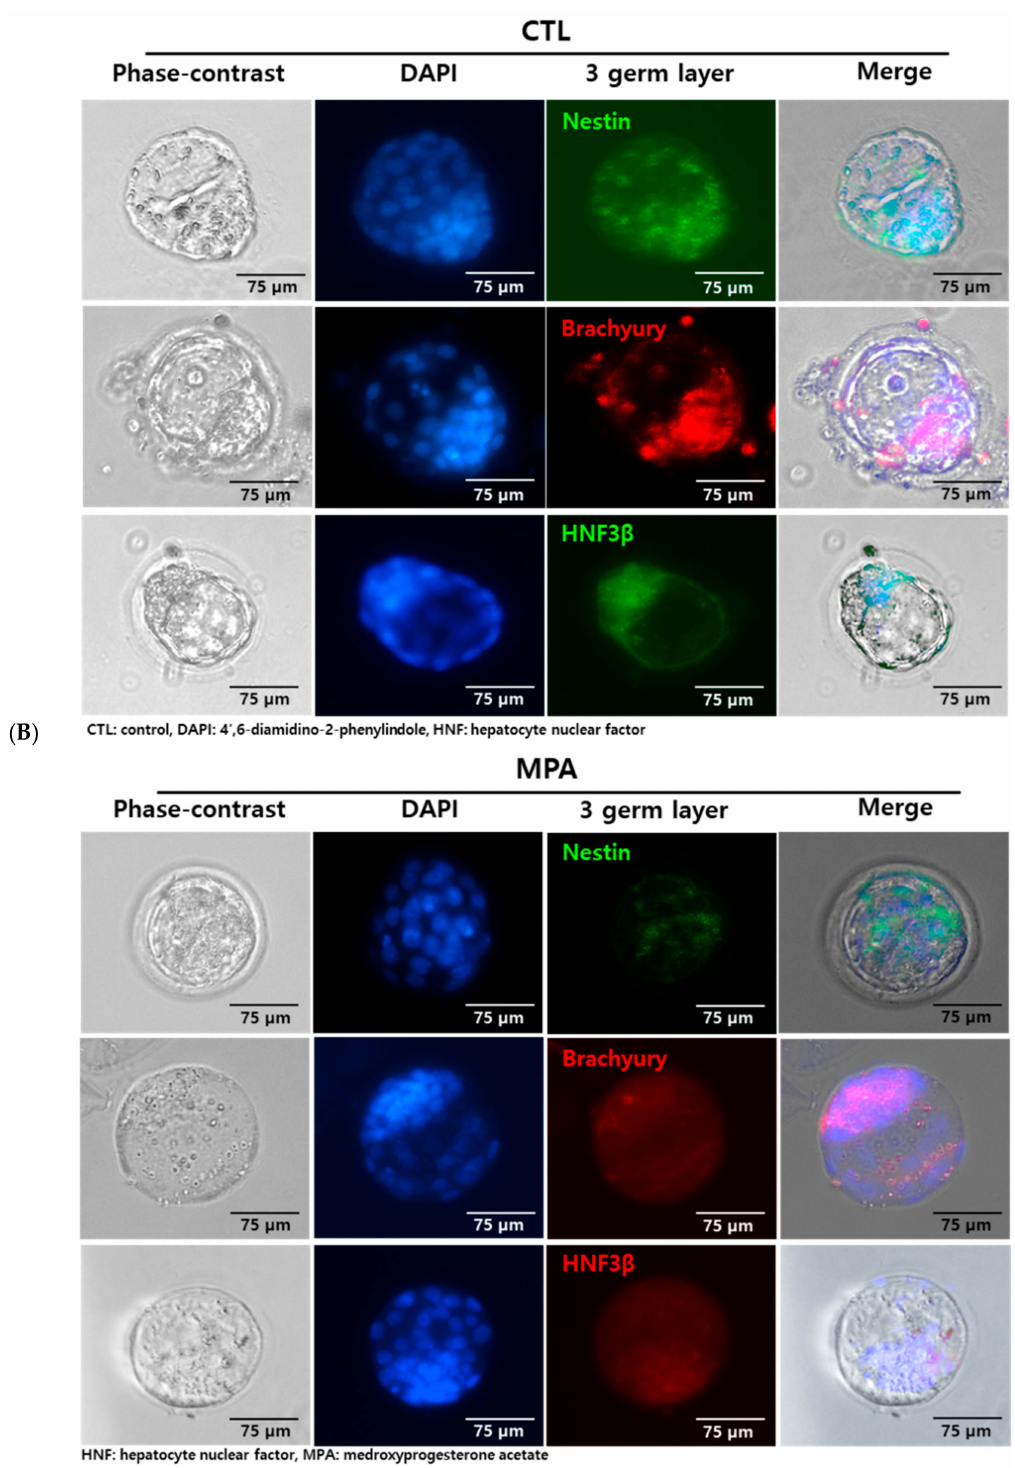
Figure 6. E ff ects of MPA on the expression of three germ layer genes on mouse embryos. Mouse blastocysts (mBLs) were cultured for 24 h, and treated with MPA at 10 − 7 M for an additional 24 h. ( A ) All tested genes were down-regulated after MPA treatment (* p < 0.05, respectively, CTL: MPA-treated mBLs). ( B ) Immunostaining of in vitro cultured mouse embryos (control vs.